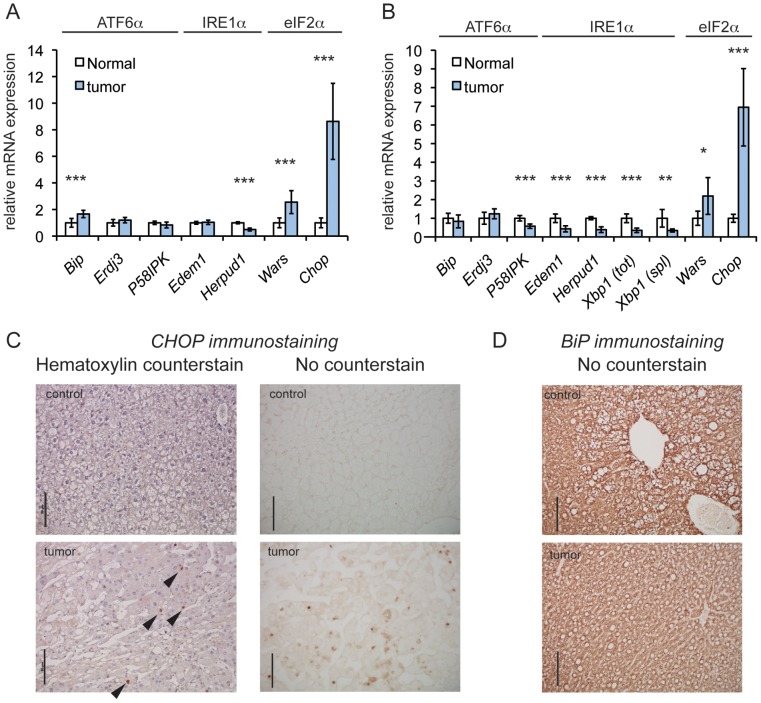
CHOP is upregulated in a genetic mouse model of HCC.(A) eIF2α-dependent genes are upregulated in tumors induced by SB mutagenesis. Relative expression of the indicated UPR genes in tumors versus normal mouse liver tissue, as quantified by transcriptome sequencing. Sequencing was performed on total RNA from mouse liver tumors generated by T2/Onc3 transposition into the Rtl1 locus (n = 8) and age-matched normal liver tissue (n = 7). The branch of UPR signaling to which each gene is most responsive is indicated. Here and in (B), error bars represent means +/− S.D.M. Here and elsewhere: *, p<0.05; **, p<0.01; ***, p<0.001. (B) qRT-PCR of SB-induced tumors confirms upregulation of Chop. Relative expression of the indicated genes quantitated by qRT-PCR from tumors arising from T2/Onc3 Rtl1 locus integrants (n = 7), compared to expression in normal tissue (n = 5). Relative expression of total (tot) and spliced (spl) Xbp1 mRNA is also shown. mRNA levels were normalized against average expression of 2 housekeeping genes (Btf3 and Ppia). (C and D) CHOP and BiP expression, respectively, in tumors from Rtl1 locus integrants and normal liver tissue from age-matched control animals using IHC. Also shown for CHOP staining are hematoxylin-counterstained samples, with exemplar CHOP-positive nuclei indicated by arrowheads. All scale bars throughout this work represent 50 µm unless indicated otherwise. The same anti-mouse immunoglobulin secondary antibody was used for both CHOP and BiP immunostains.